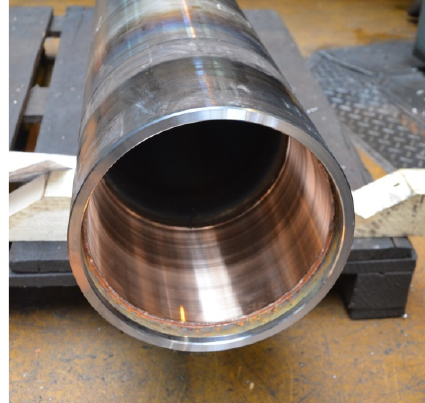
Figure 5. Bronze layer.